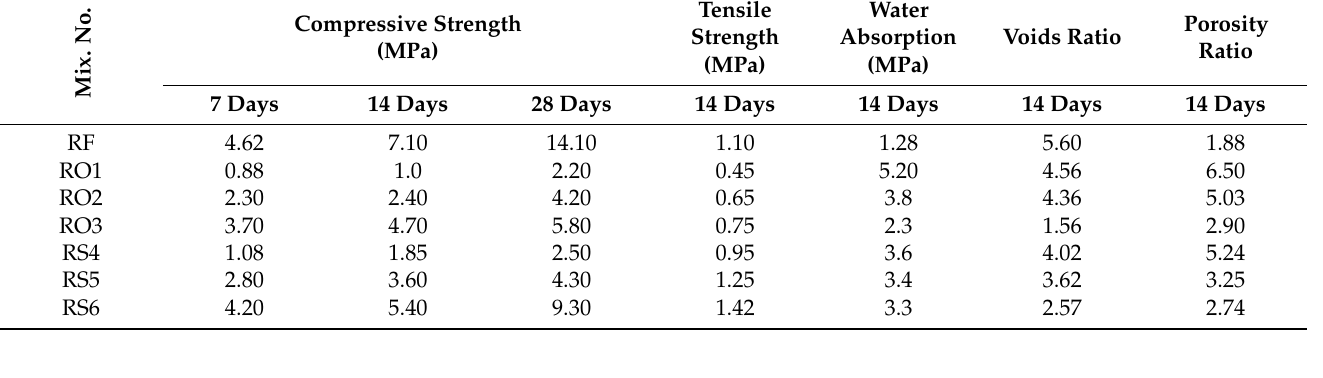
Table 7. Mechanical properties of samples after 7, 14, and 28 days.